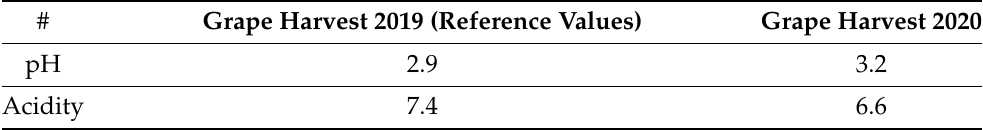
Table 3. Site 1—Comparison between relevant parameters.